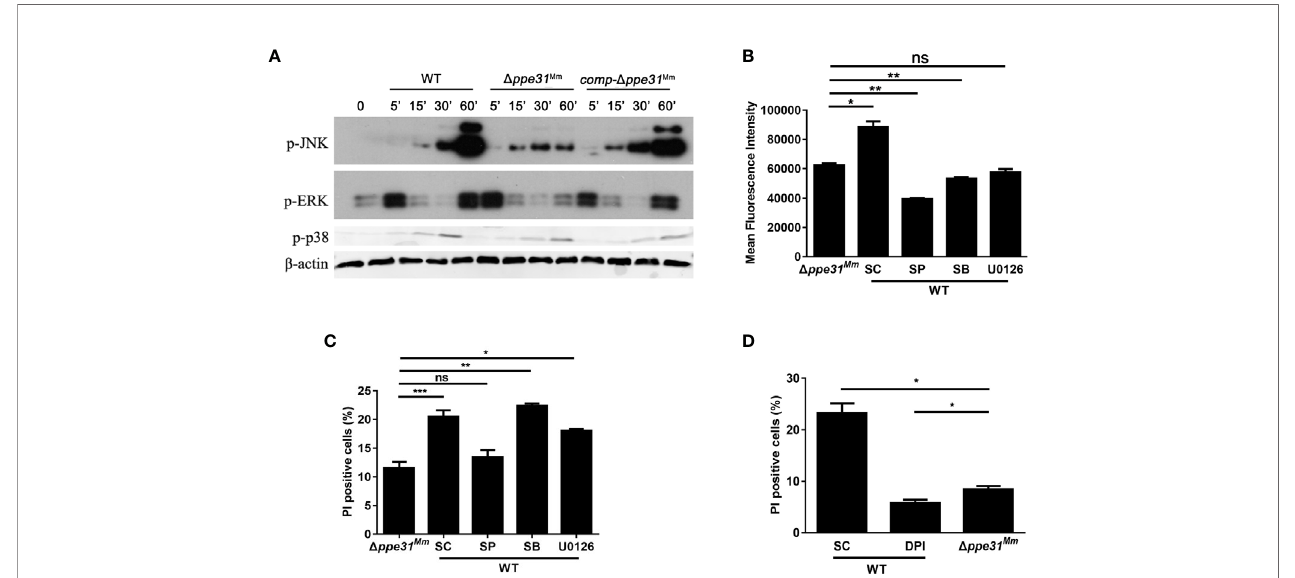
FIGURE 4 | Infection with D ppe31 Mm reduces cell death through JNK-dependent signaling. (A) BMDMs were infected with WT, D ppe31 Mm or comp- D ppe31 Mm (MOI = 10) for the indicated periods of time, and then subjected to Western blot analysis using antibodies raised to p-ERK1/2, p-p38, p-JNK, and b -actin. (B) BMDMs were pretreated with the following MAPK signaling pathways inhibitors U0126 (20 m M), SB203580 (SB; 10 m M), or SP600125 (SP; 20 m M) for 1h, and then infected with WT, D ppe31 Mm or comp- D ppe31 Mm for 30 min, Cells were then incubated with DCFH-DA and analyzed immediately for ROS generation by fl ow cytometry. (C) BMDMs were pretreated with U0126 (20 m M), SB (10 m M), or SP (20 m M) for 1h, and then infected with WT, D ppe31 Mm or comp- D ppe31 Mm for 24h, cells were stained with PI and then examined by fl ow cytometry. (D) BMDMs were infected with WT, D ppe31 Mm or comp- D ppe31 Mm (MOI = 10) in the presence or absence of DPI (10 m M). After 24h, cells were then stained with PI and analyzed immediately for cell death using fl ow cytometry. Data are shown as mean±S.E.M. of three independent experiments. * p < 0.05, ** p < 0.01, *** p < 0.001. WT, wild-type; M, marinum ; UI, uninfected; SC, solvent control (0.1% DMSO); ns, no signi fi